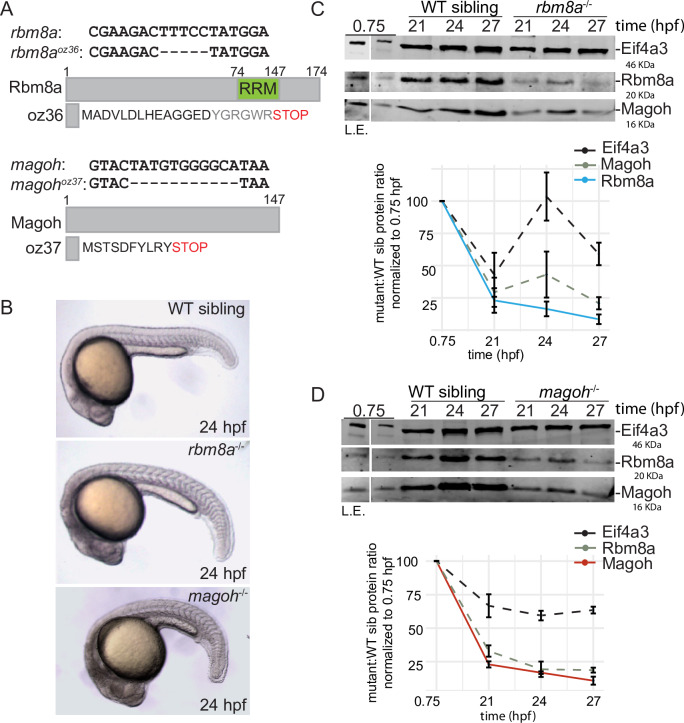
Zebrafish rbm8a and magoh mutant embryos show gradual loss of maternally contributed Rbm8a and Magoh proteins during early development.A. Schematic illustrating the rbm8aoz36 and magohoz37 alleles and the predicted proteins they encode. Full-length Rbm8a and Magoh proteins are also shown. RRM: RNA Recognition Motif. B. Whole mount images of live wild-type sibling, rbm8a mutant, and magoh mutant embryos at 24 hpf. Increased grayness in the head region of homozygous rbm8a and magoh mutant embryos indicates cell death. C. Top: Western blots showing EJC protein expression in wild type (WT) sibling and rbm8a-/- mutant embryos. Antigens detected are listed on the right and embryo genotype is listed above the blot. Developmental time points (hpf) are indicated above each lane. Protein from five (0.75 hpf) or ten embryos (all other time points) was loaded in each lane. A longer exposure (L.E.) of the 0.75 hpf lane is on the left. Bottom: Line graphs showing the amount of protein (per embryo) in the mutant embryos compared to wild-type sibling as a percent of protein present at 0.75 hpf. Error bars represent standard error of means. D. Top: Western blots as in C showing EJC protein expression in wild type (WT) sibling and magoh-/- mutant embryos. Bottom: Line graphs showing protein quantification as in C.